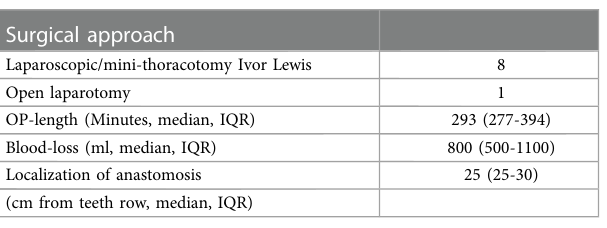
TABLE 2 Surgery characteristics. TABLE 1 Patient characteristics ( n